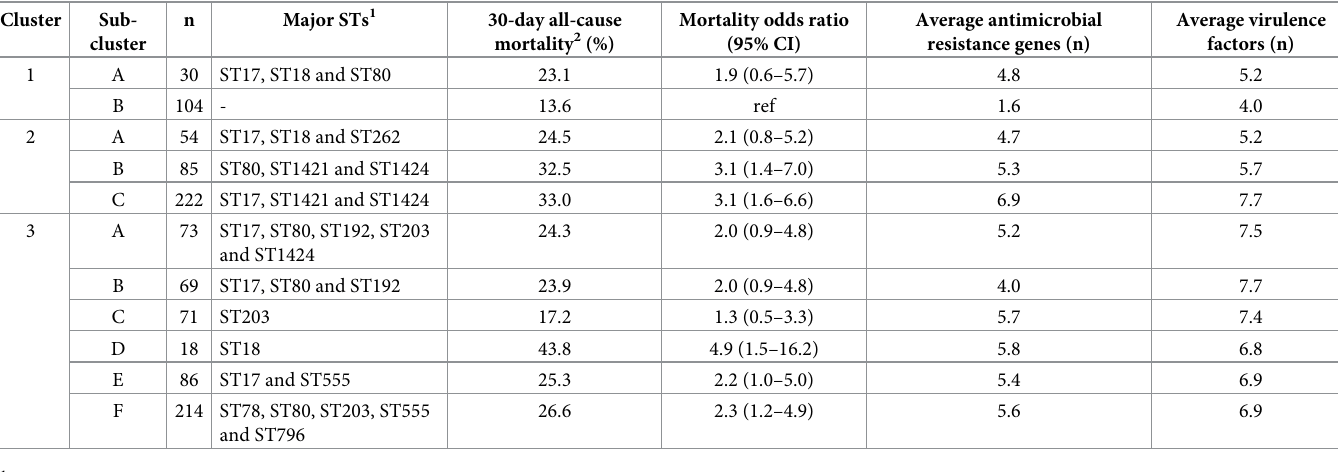
Table 3. Isolate characteristics based on the three phylogenetic clusters.